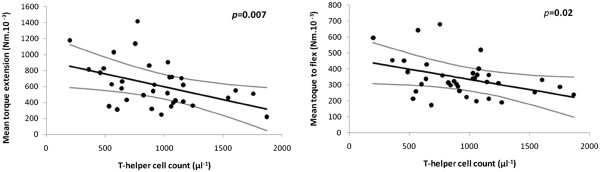
Relationship of rigidity to T-helper count in core group, after adjustment for demographic characteristics, and, in the case of flexor-rigidity, for natural-killer count. (Standardised, as appropriate, to time since diagnosis 6 years, body weight 80 kg, natural-killer count 250 μl-1.) Regression line and 95% CI are shown for flexor- and extensor-rigidity on T-helper count.